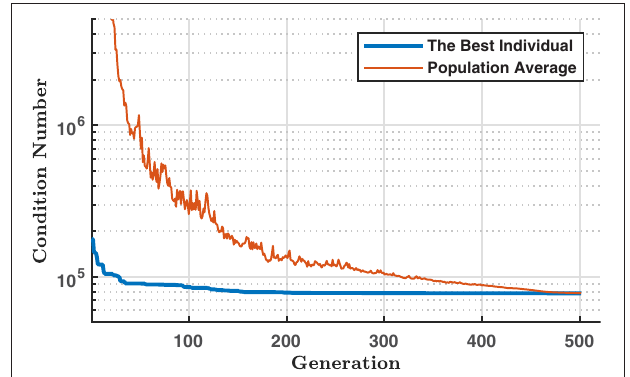
FIGURE 2 | Convergence of the GA optimization in terms of condition number.